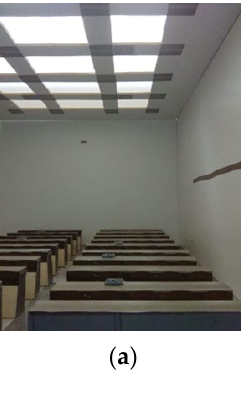
Figure 7. Comparison between the interior of the: ( a ) developed model; ( b ) and the real environment of the chosen classroom of the Leonardo da Vinci building of the Campus of Rabanales at the Uni- versity of Córdoba (Spain). University of C ó rdoba